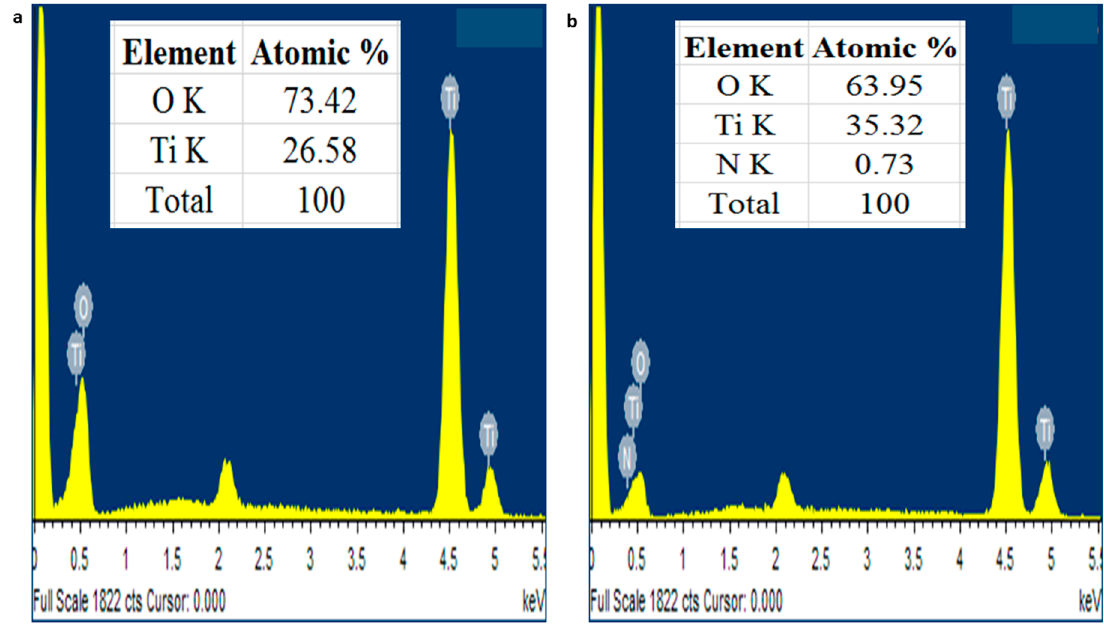
Figure 3. EDX pattern of ( A ) TiO 2 nanoparticles and ( B ) N-doped TiO 2 nanoparticles.